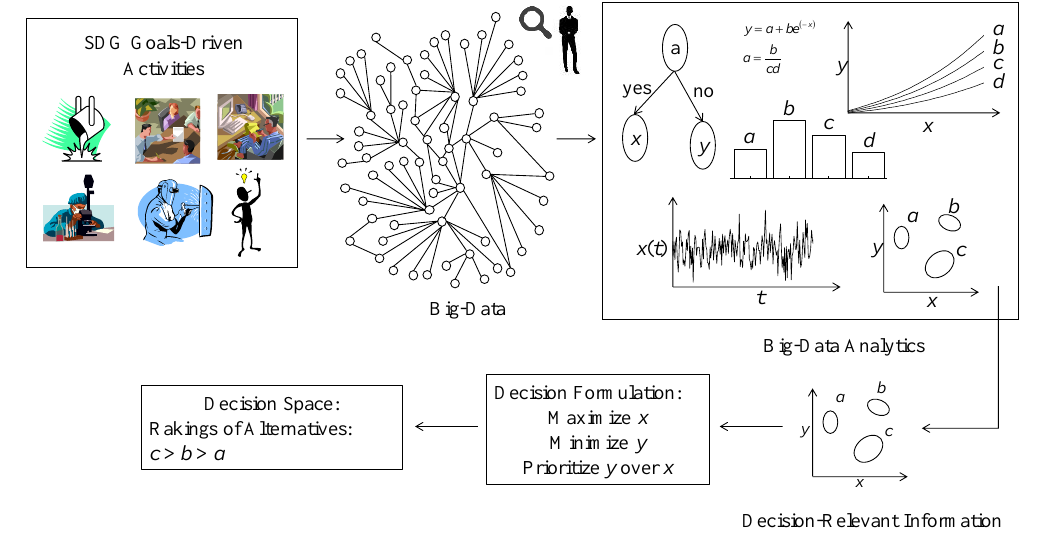
Figure 2. Proposed decision-making framework.